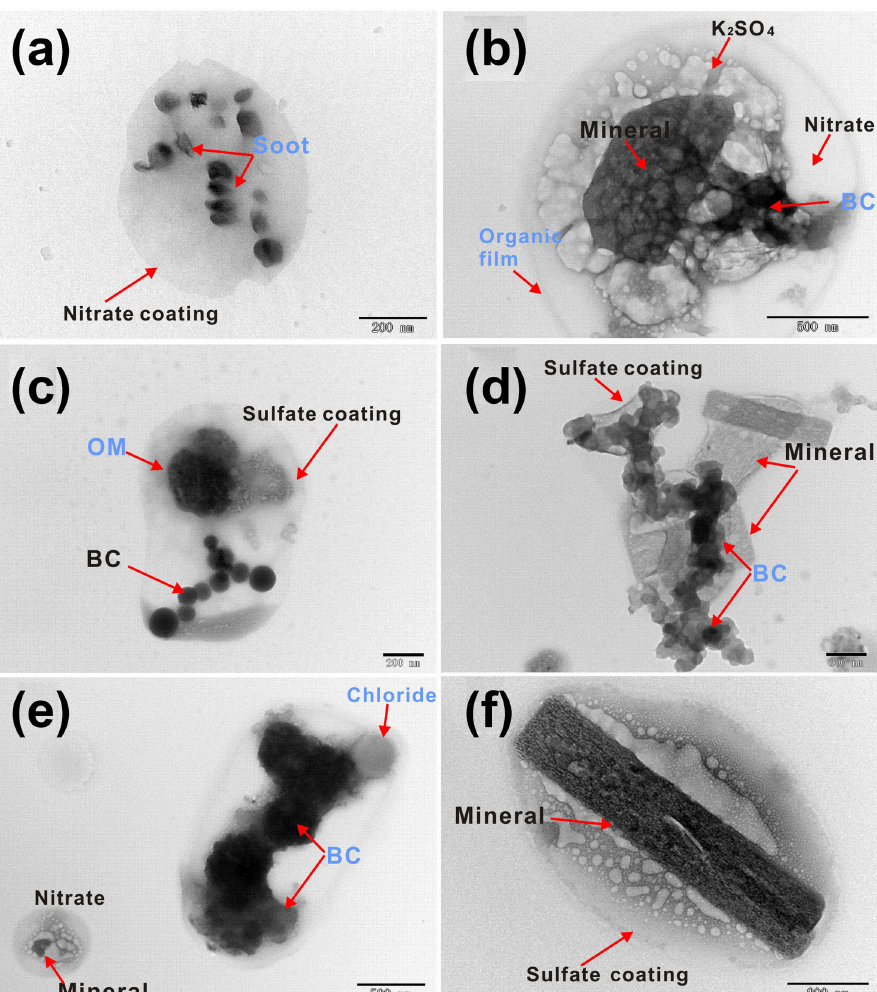
Figure 6. Examples of different salt-coating conditions of BC, OM, and mineral dust for individual particles in the atmosphere from various glacier basins in the northeastern Tibetan